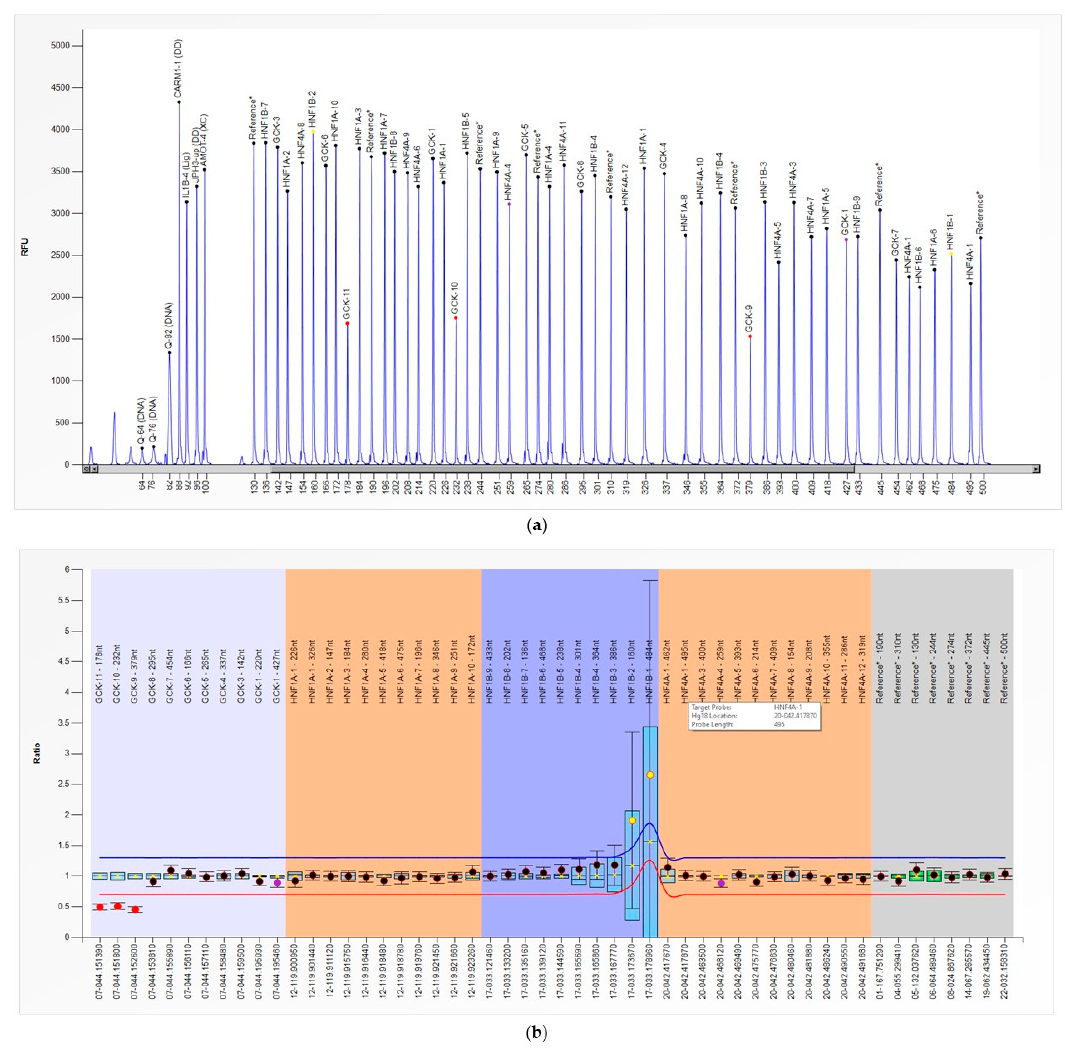
Figure 3. ( a ) MLPA electropherogram from the patient carrying the heterozygous deletion of GCK exons 8–10. Specific peaks ( GCK -9, GCK -10, and GCK -11) show reduced height. ( b ) MLPA results from comparative analysis experiment obtained by Coffalyser.NET Software (MRC Holland, Amsterdam, Netherlands). The final ratio of exons 8–10 probes was <0.80 (normal range 0.80 < FR < 1.20), indicating a heterozygous deletion. For GCK , the exon numbering from the LGR_1074 sequence is used.